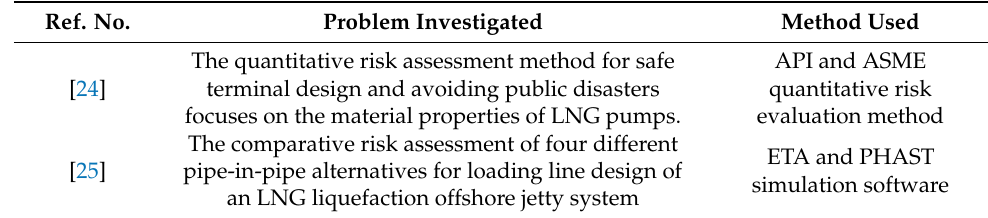
Table 3. Literature review for research Area 3—Risk related to LNG terminals and stations. Ref.